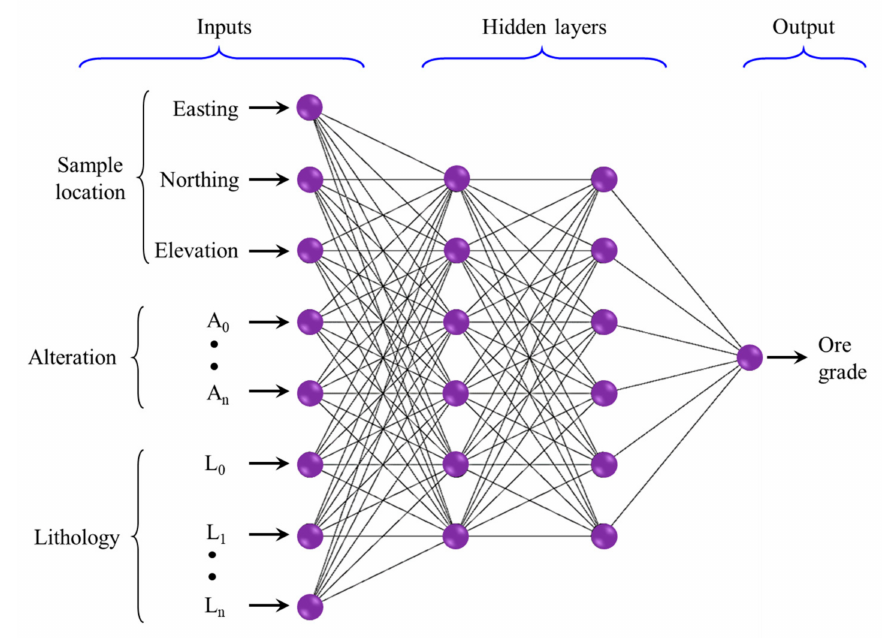
Figure 10. Proposed NN model architecture, adapted from